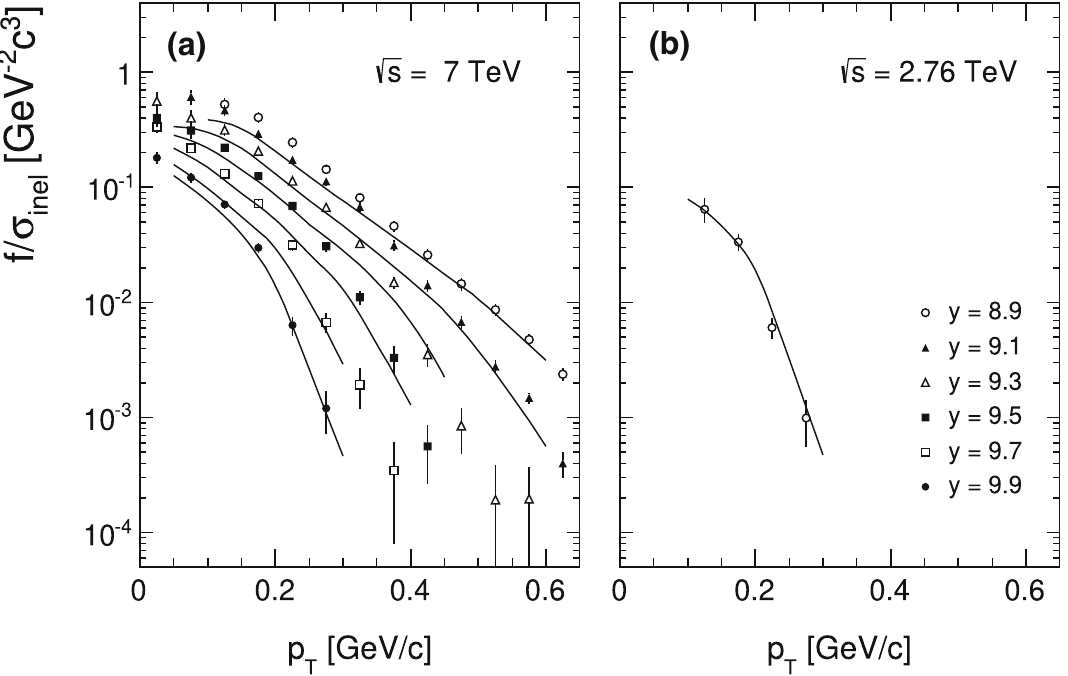
√ s = 7 TeV (panel a ) and 2.76 TeV (panel b ). Full lines ISR prediction at